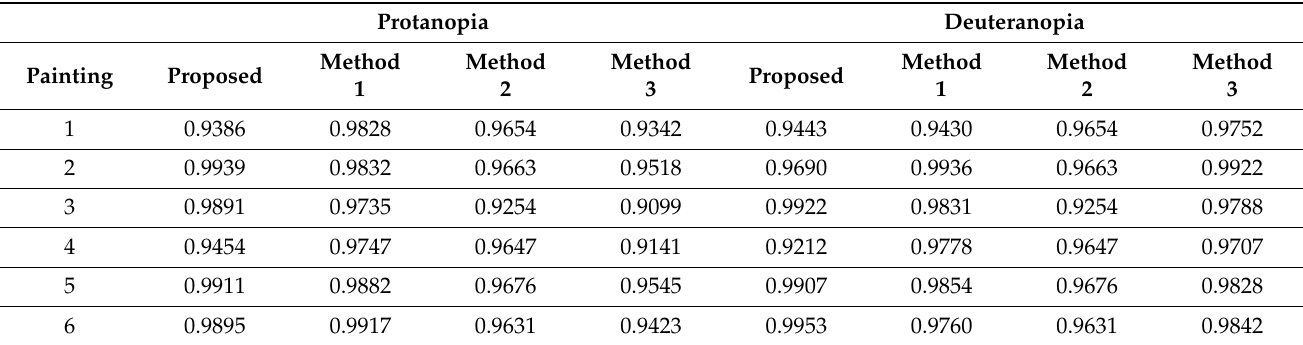
Table 3. Feature similarity index (FSIMc) values obtained by the four methods for protanopia and deuteranopia considering the paintings reported in Figure 5.